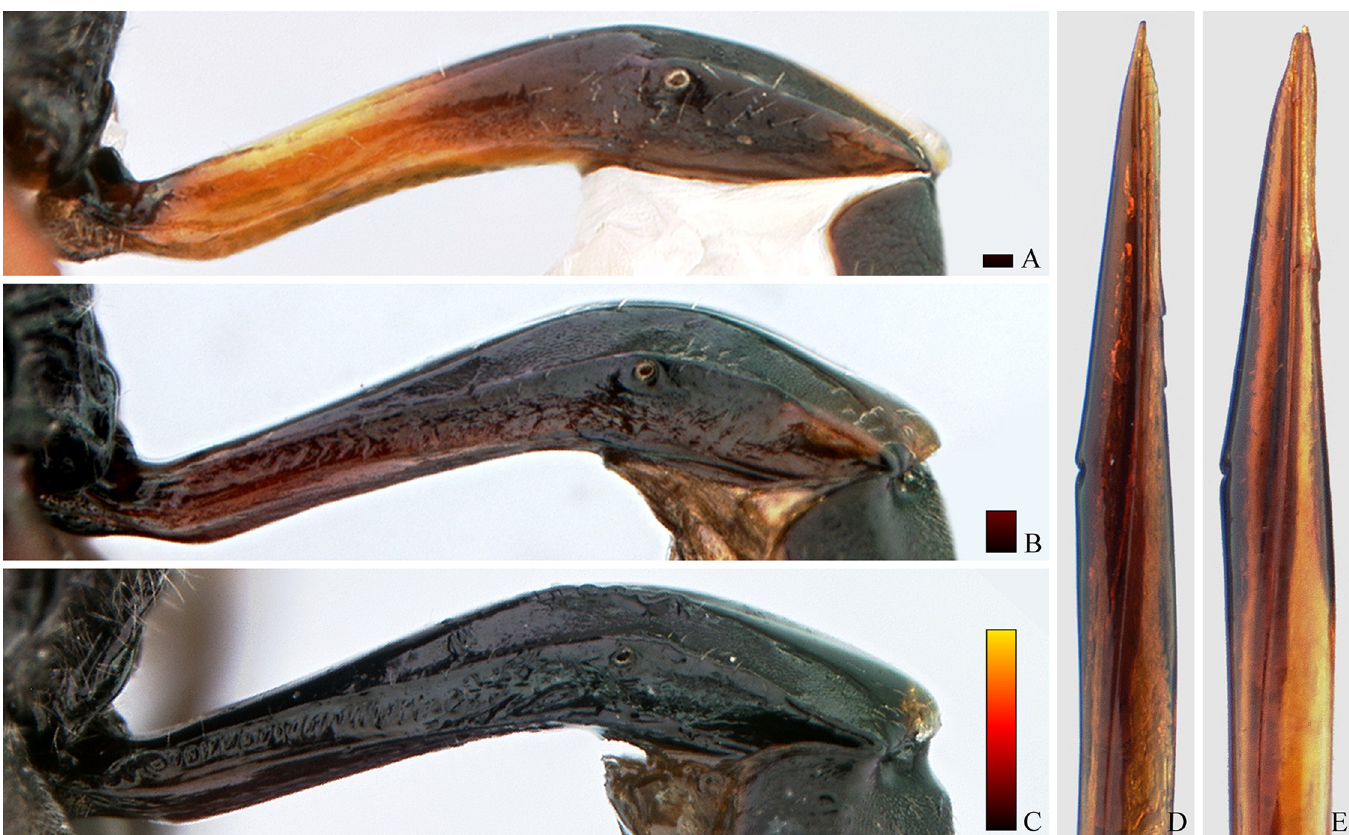
Fig 15. Cryptoxenodon metamorphus sp. nov. from the paratype series. Female petiole and ovipositor apex. (A-C), First tergite, left side. (A) FAS4613, Alt. 36m, Brazil/PA. (B) UFES45548, Alt. 115m, Brazil/BA. (C) FAS331, Alt. 561m, Brazil/ES. (D-E), apex of ovipositor, left side. (D) FAS333, Alt. 501m, Brazil/ES. (E) FAS4613, Alt. 36m, Brazil/PA. Bars are proportional to the